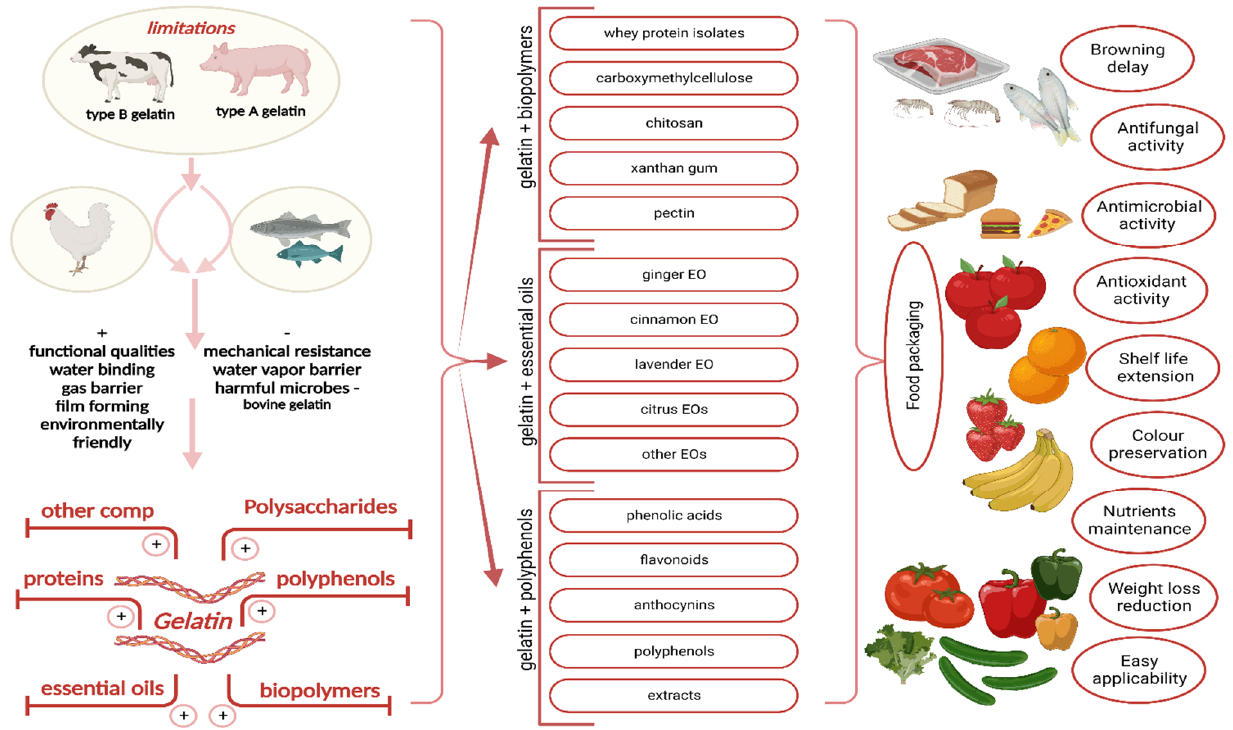
Figure 1. Schematic representation of gelatin matrix incorporated with functional materials for improving the characteristics of the composite films.